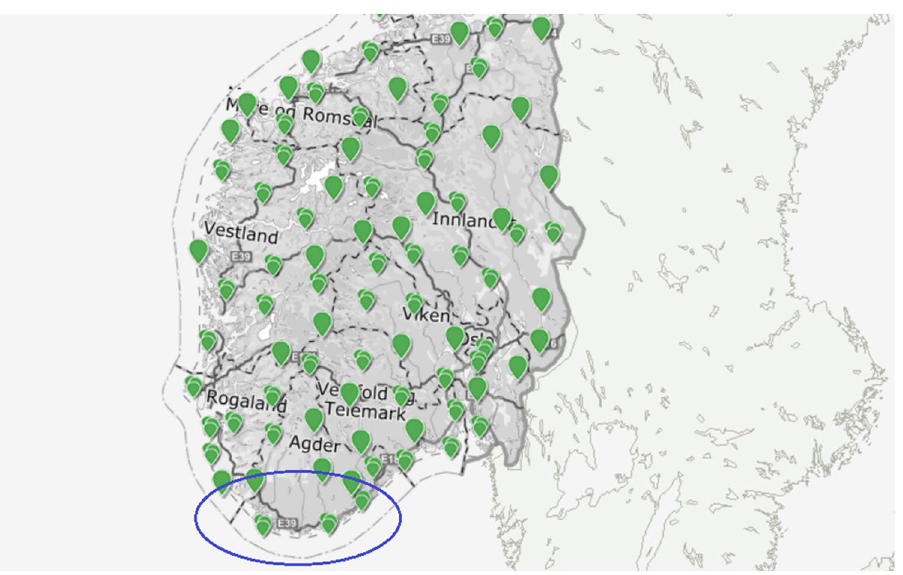
Figure 3. Wind speed measurements locations according to Norwegian Meteorological Institute 21 , a blue circle indicates the area of interest, https:// sekli ma. met.